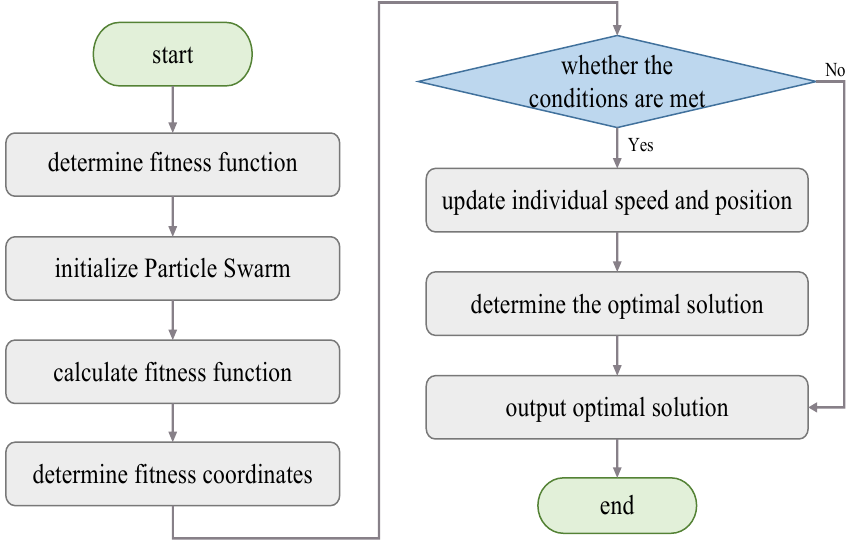
Figure 2. Particle swarm algorithm flow chart.